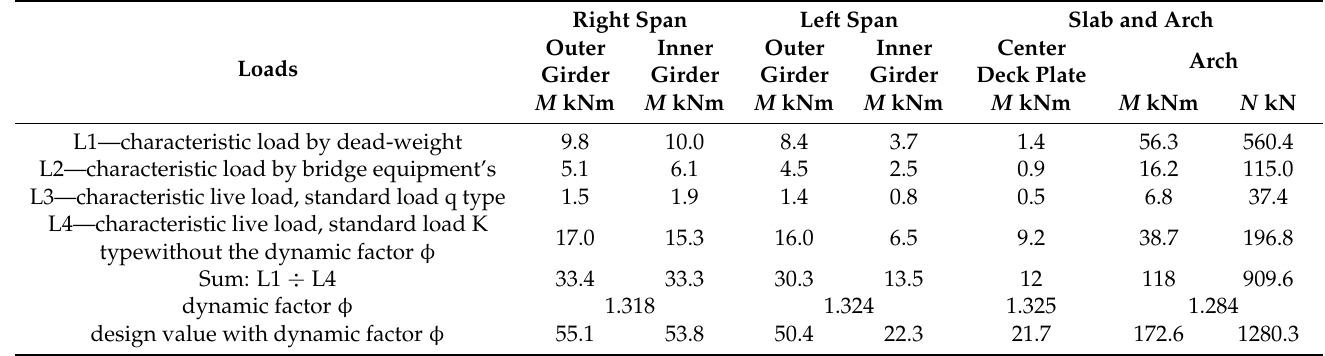
Table 4. Characteristic and design value of internal forces under designed loads.